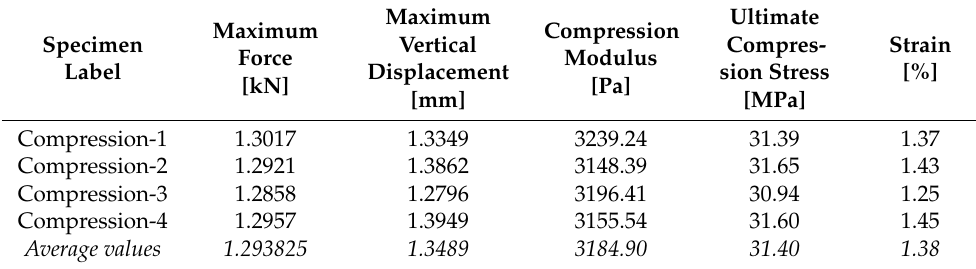
Table 7. Mechanical characteristics of honeycomb CPE subjected to compressive testing.